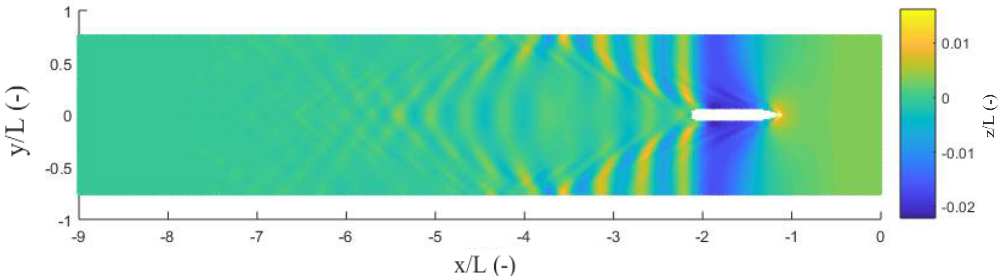
Figure 9. Generated wave field in the rectangular canal at 𝐹 ℎ = 0.77.